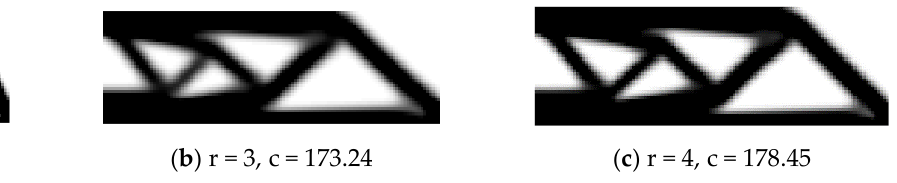
Figure 12. Optimization results of the SIMP method.